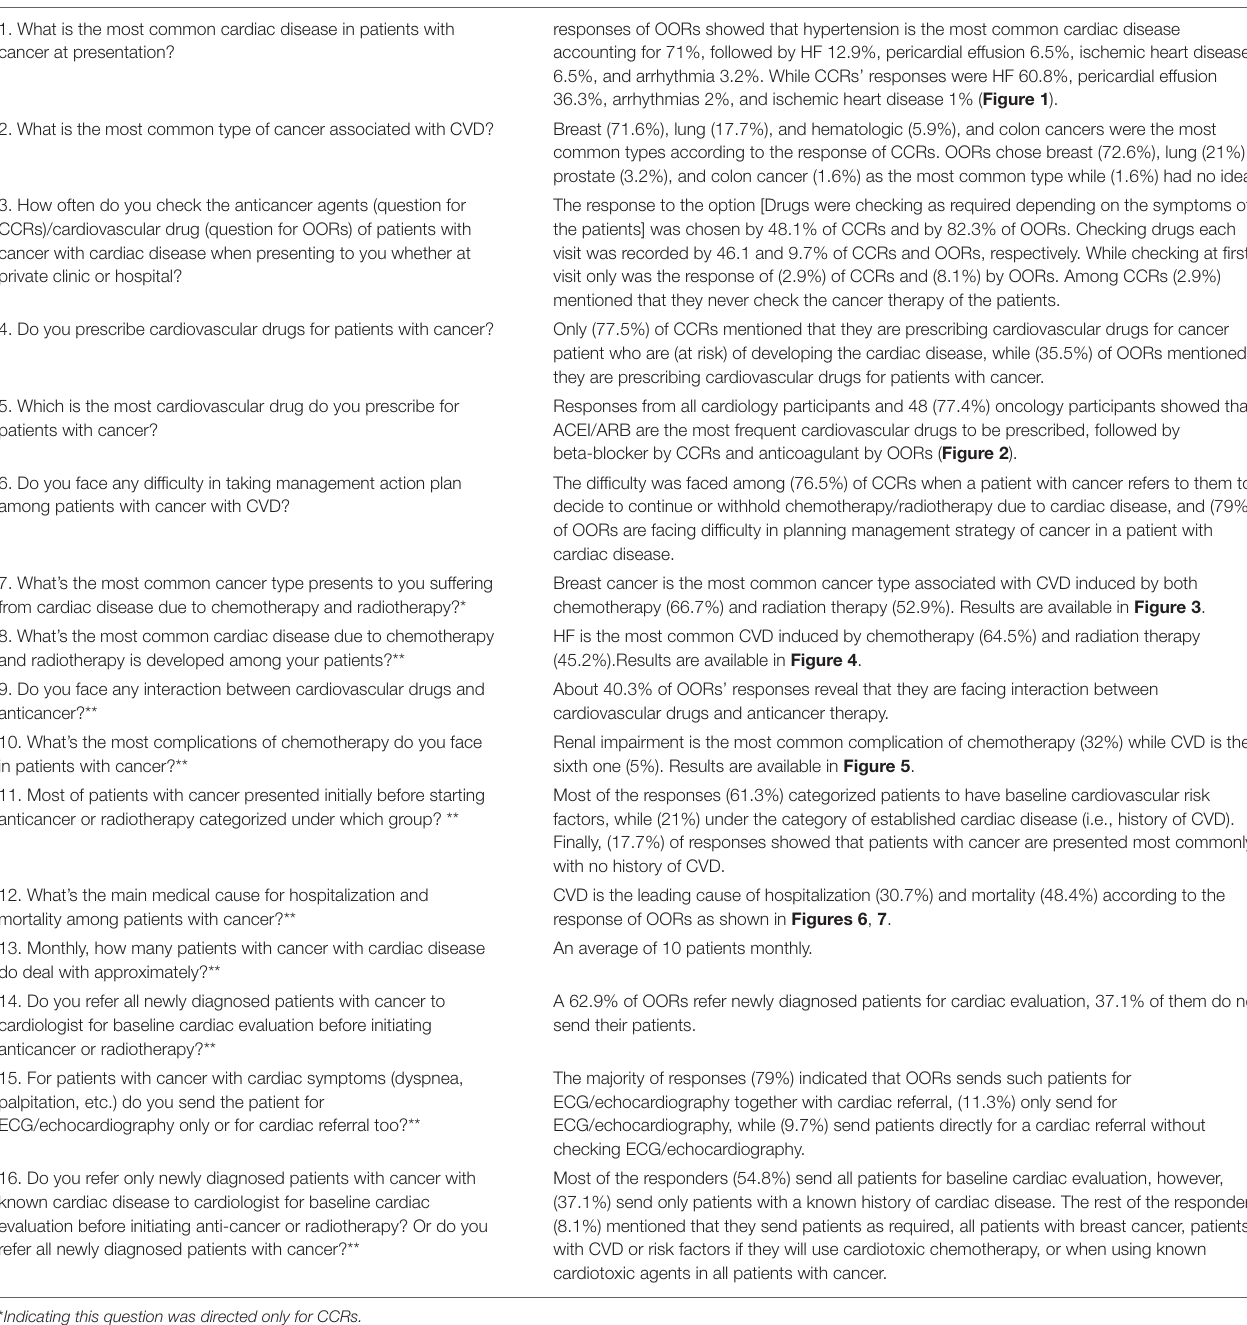
TABLE 2 | Questions about current practice regarding patients with